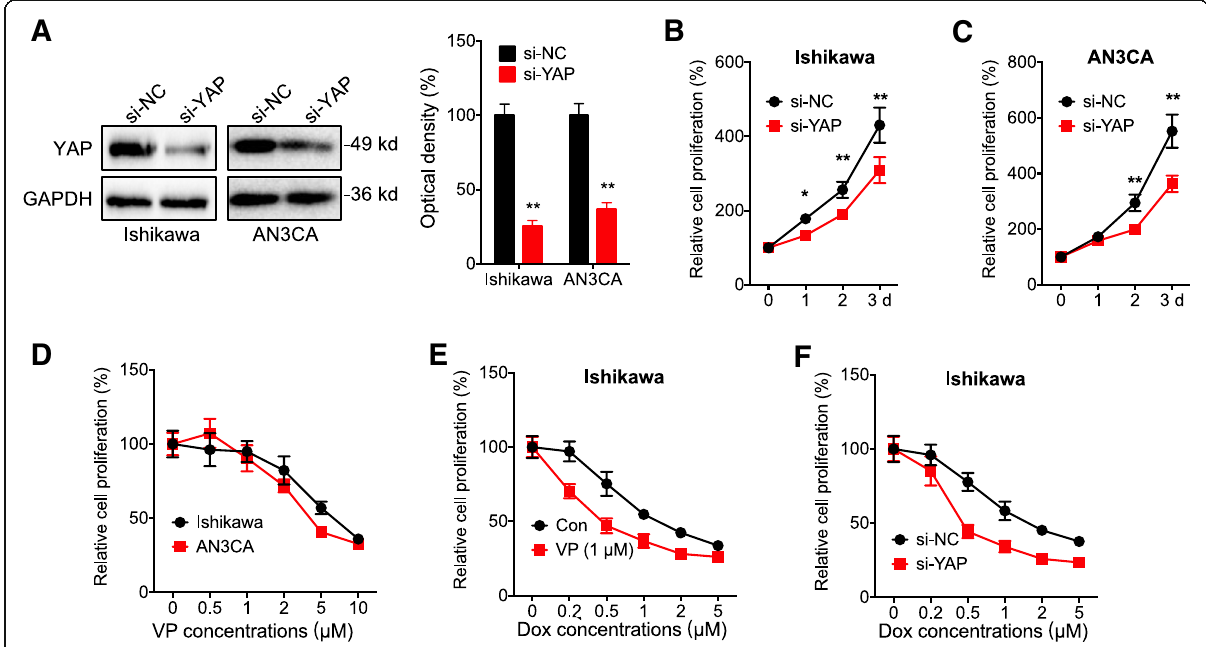
Fig. 2 Targeted inhibition of YAP can suppress the proliferation and increase the chemosensitivity of EC cells . ( a ) Cells were transfected with siRNA negative control (si-NC) or si-YAP for 24 h, the expression of YAP was measured by western blot analysis (left) and quantitatively analyzed (right); Ishikawa ( b ) or AN3CA ( c ) cells were transfected with si-NC or si-YAP for the indicated time periods, the cell proliferation was measured by CCK-8 kit; ( d ) Ishikawa or AN3CA cells were treated with increasing concentrations of VP for 48 h, the cell proliferation was measured by CCK-8 kit; ( e ) Ishikawa cells were pre-treated with or without 1 μ M of VP and then further treated with increasing concentrations of Dox for 48 h, the cell proliferation was measured by CCK-8 kit; (F) Ishikawa cells were pre-transfected with si-NC or si-YAP for 12 h and then further treated with increasing concentrations of Dox for 48 h, the cell proliferation was measured by CCK-8 kit. Data are presented as means ± SD of three independent experiments. * p < 0.05, ** p < 0.01 compared with